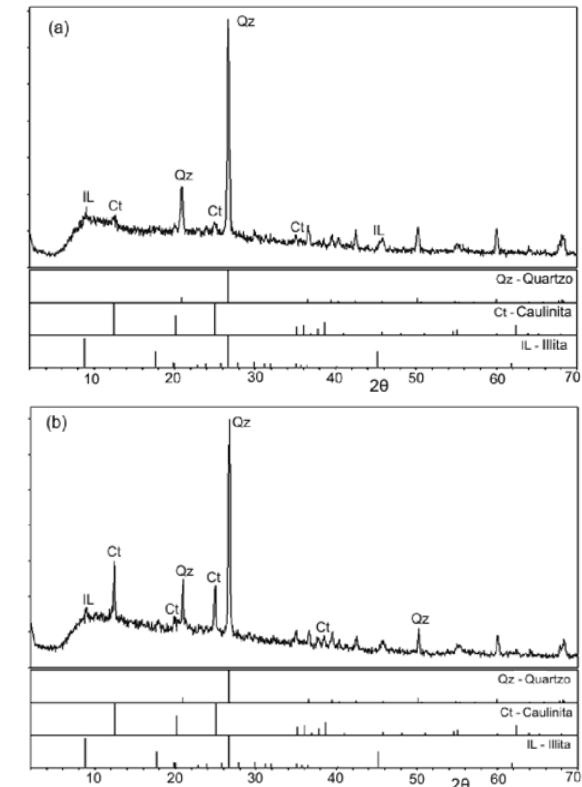
Figura 3. Difratogramas de raios X dos Cambissolos Háplicos das topossequências Fazenda Água Limpa (FAL) e Sobradinho: (a) fração TFSA do horizonte CR do CX da topossequência FAL; (b) fração TFSA do horizonte CR do CX da topossequência Sobradinho. As barras represen- tam a posição característica (valor 2 θθθθθ ) e a inten- sidade dos picos minerais nos